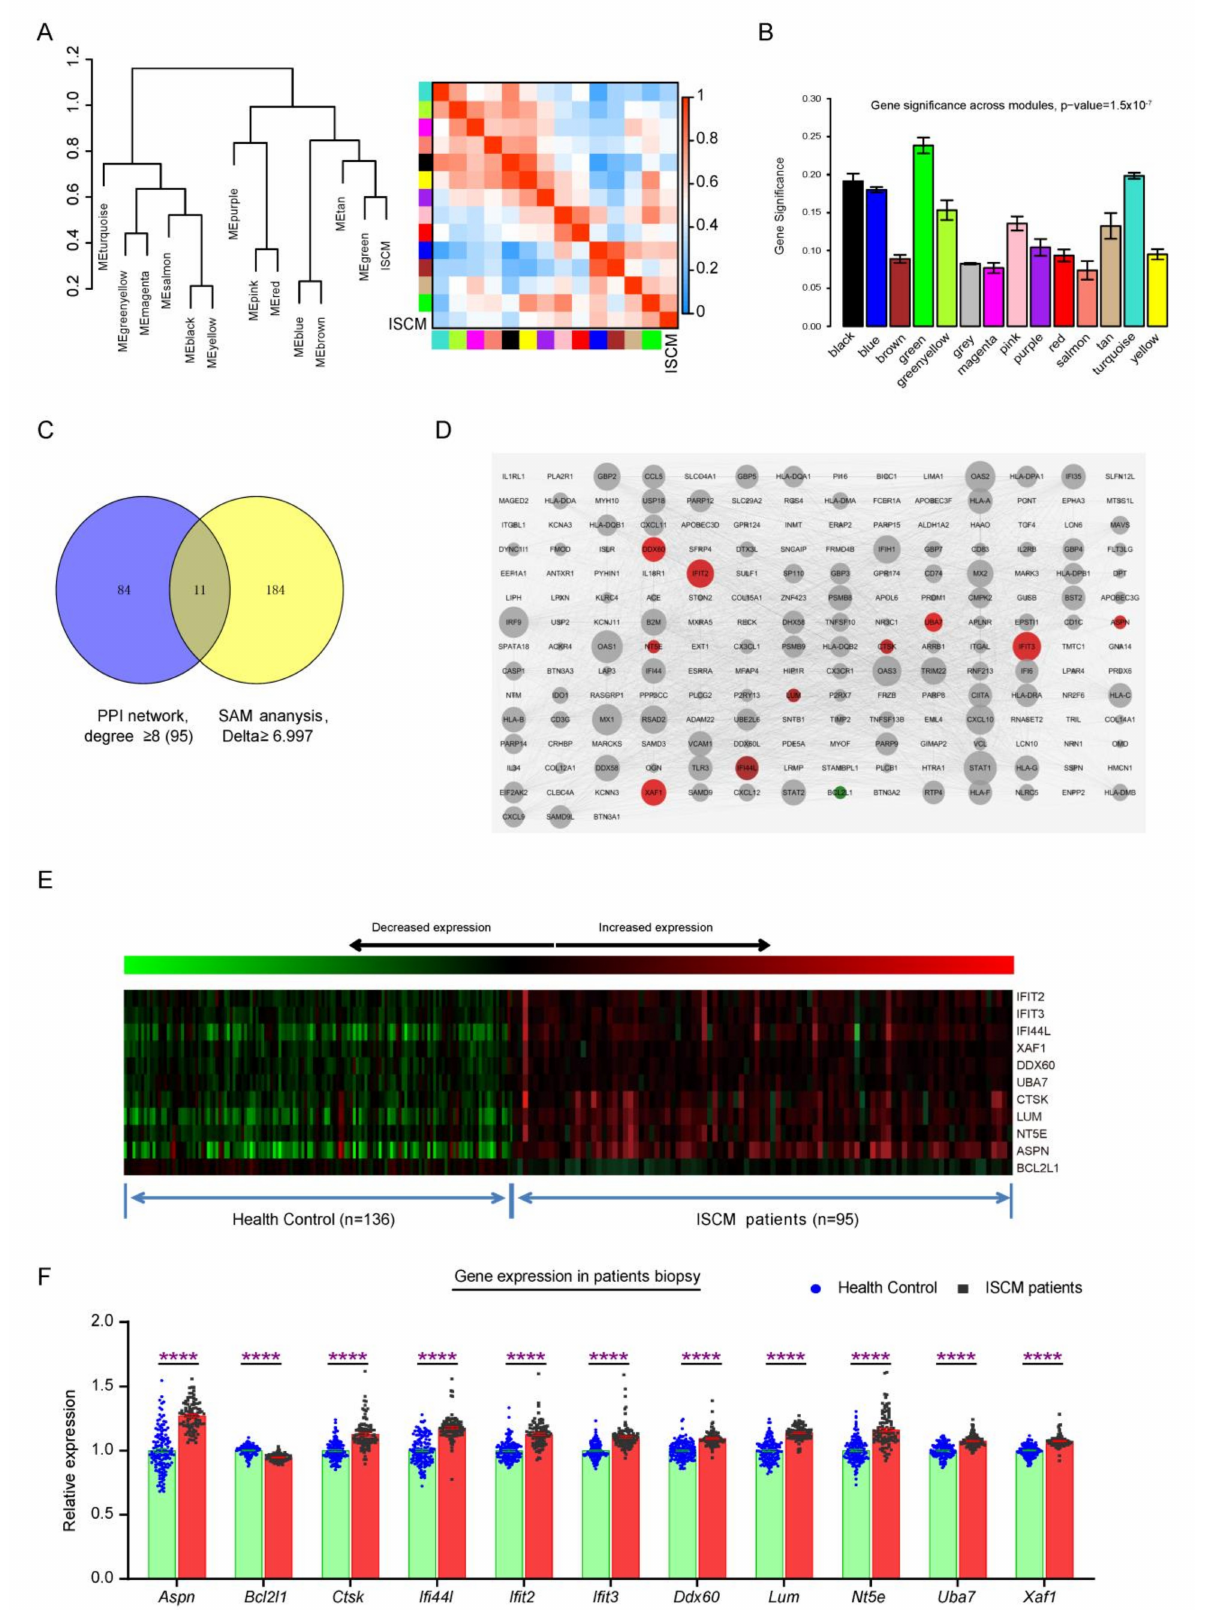
Figure 2. Identified the signature genes significantly associated with ISCM. ( A ) Clustering dendrogram of the eigengenes and adjacency with ISCM dissimilarity based on topological overlap. The left panel shows a hierarchical clustering